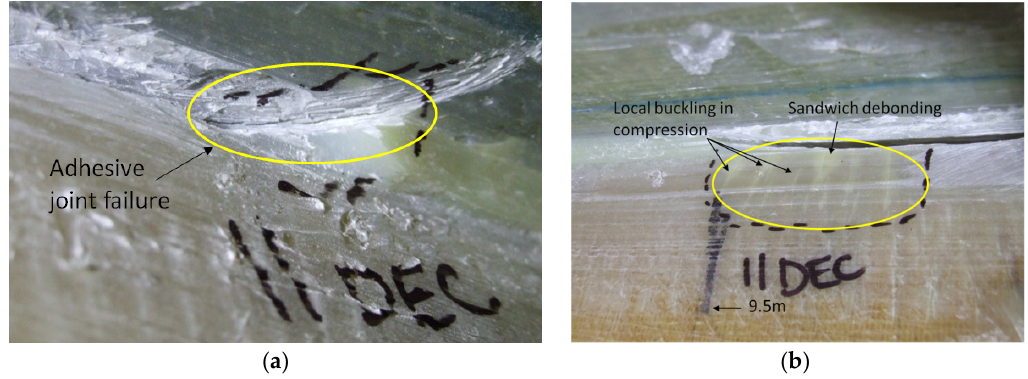
Figure 15. ( a ) Adhesive debonding outside the web box at 8.5 m; ( b ) local buckling under compression and sandwich debonding outside the web box at 9.5 m.